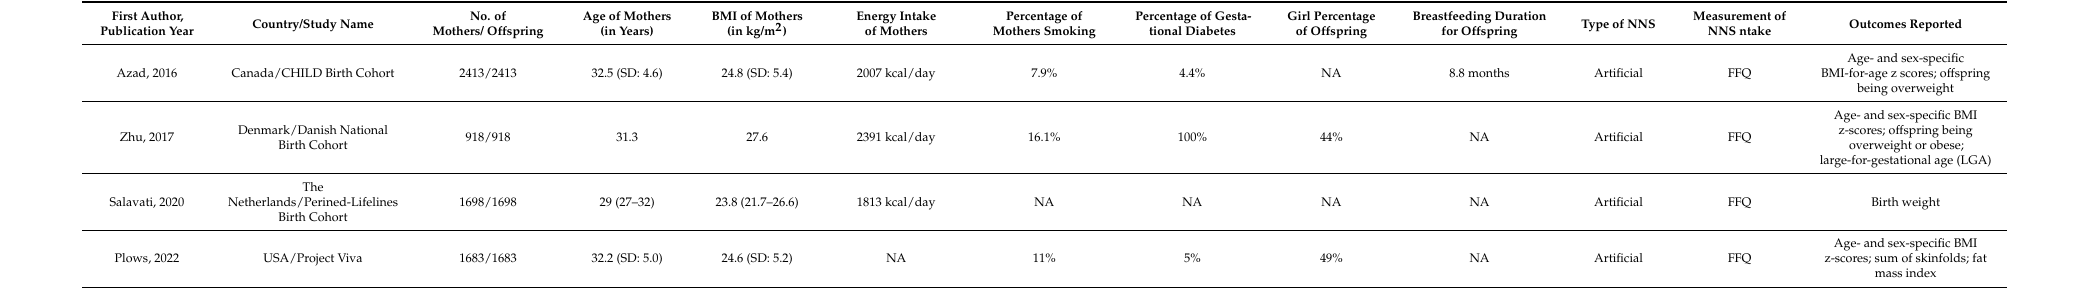
Table 1. Characteristic descriptions of the included